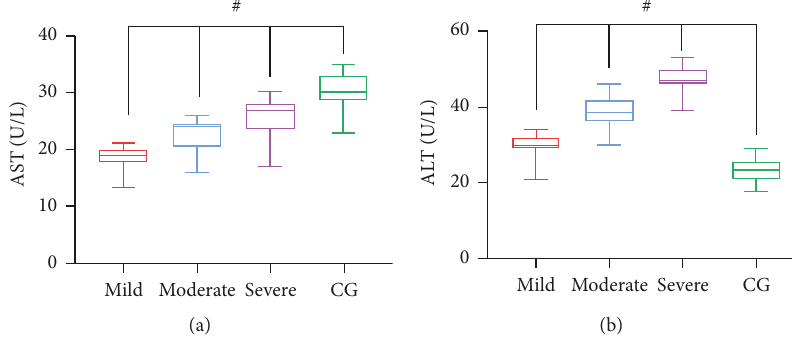
Figure 2: Comparison of liver function indicators of patients in each group.